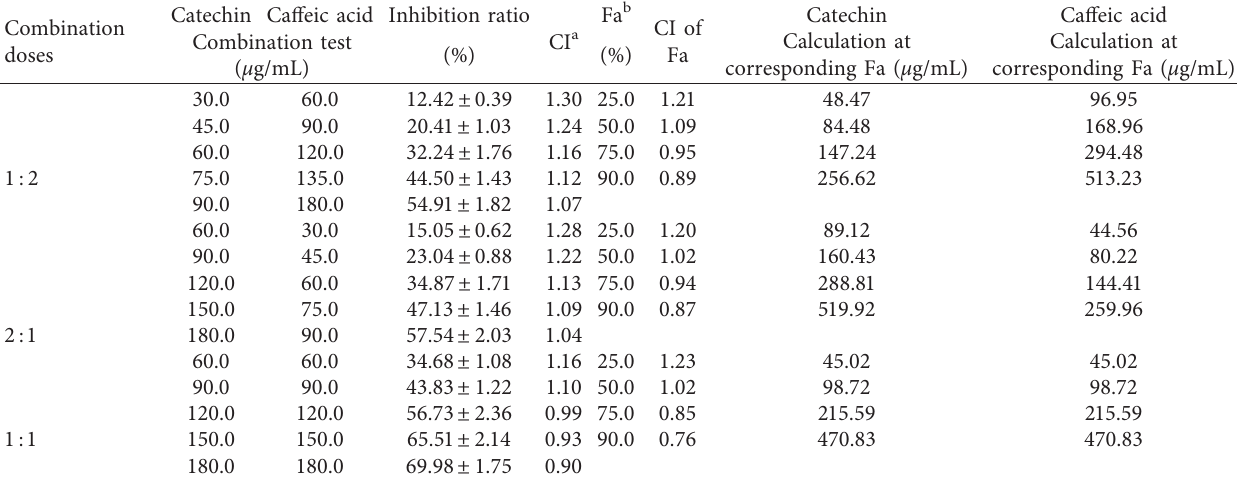
Table 2: The interactions between catechin and caffeic acid on inhibition of α -glucosidase Catechin Caffeic acid Inhibition Combination doses